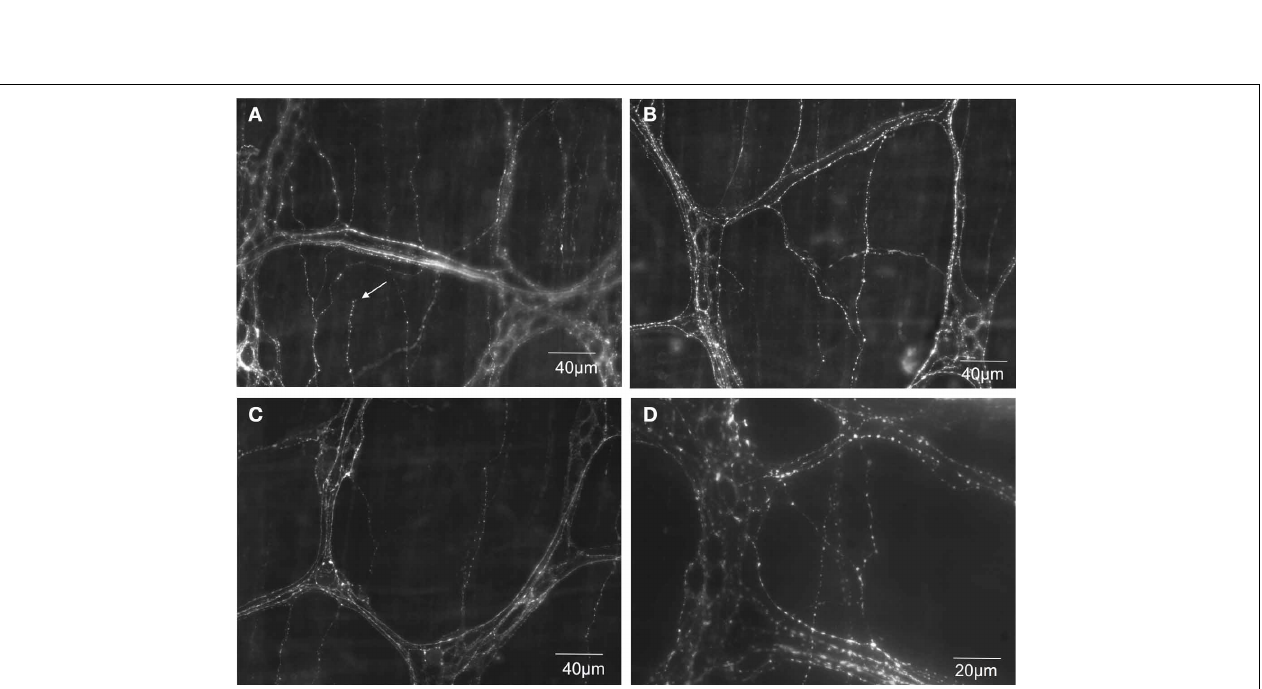
FIGURE 4 | Tetrodotoxin abolishes stretch-activated calcium transients in varicosities and axons of spinal afferent nerve terminals that innervate the same myenteric ganglion, as shown in Figure 3. The